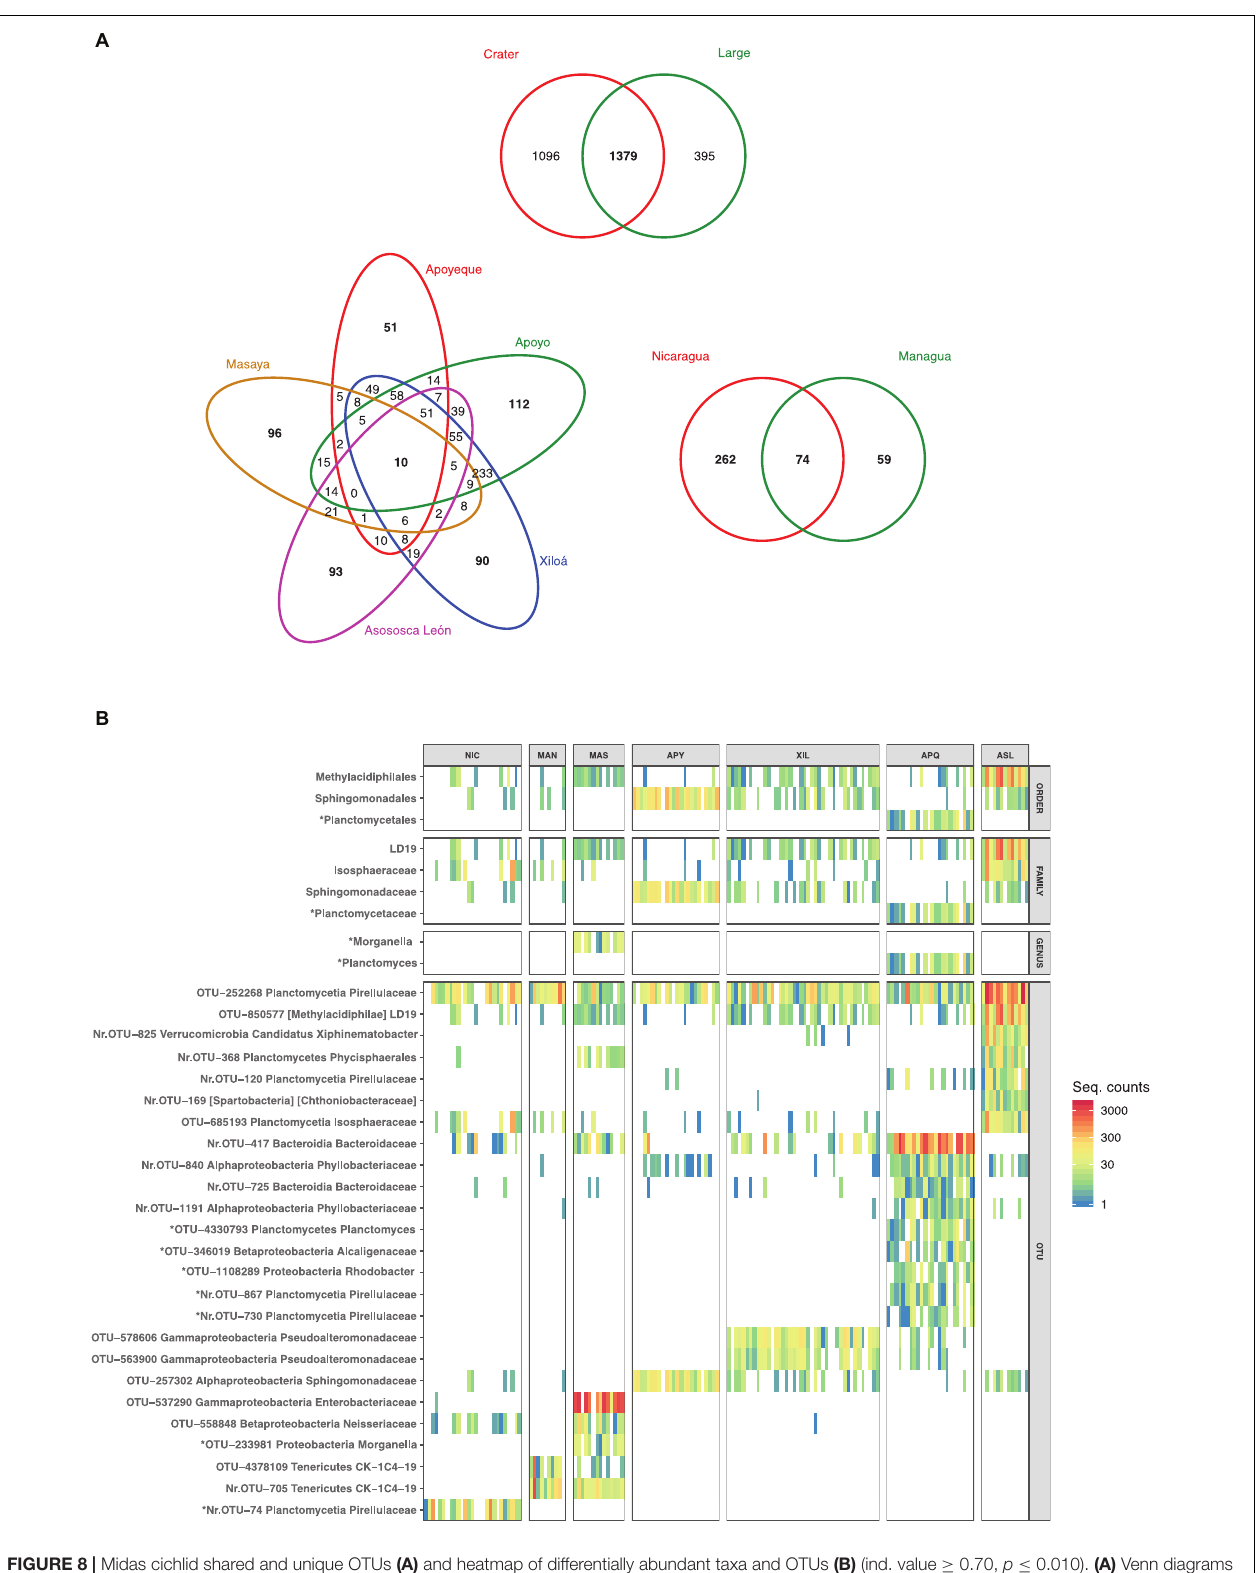
FIGURE 8 | Midas cichlid shared and unique OTUs (A) and heatmap of differentially abundant taxa and OTUs (B) (ind. value ≥ 0.70, p ≤ 0.010). (A) Venn diagrams display shared and unique OTUs between large and crater lakes (top), among the five crater lakes (left, only crater-specific OTUs) and between the two large